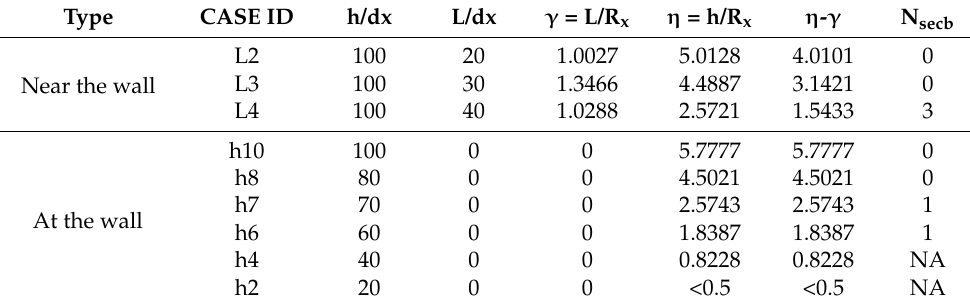
Figure 4. Computational domain. Table 1. Case parameters.